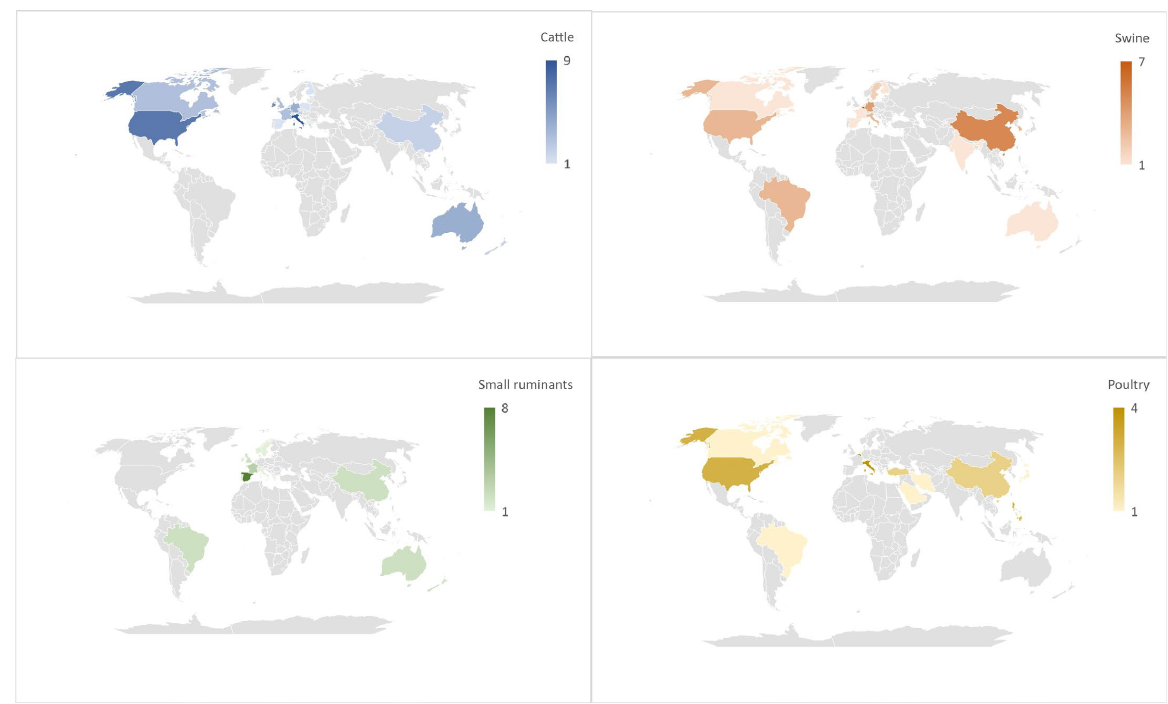
Figure 2. Number of articles related to PLF published worldwide in relation to the species (blue: cattle; orange: swine; green: sheep and goat; yellow: poultry). cattle; orange: swine; green: sheep and goat; yellow: